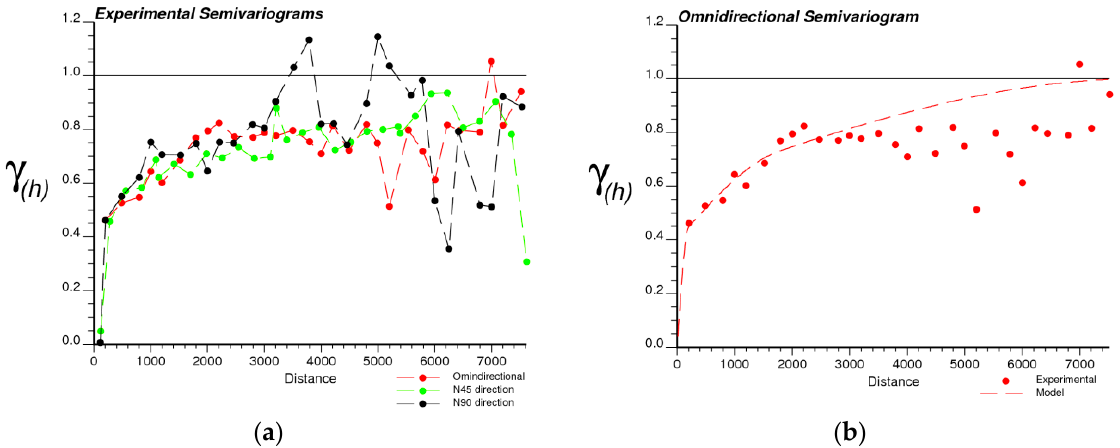
Figure 9. ( A ) Experimental variograms for normal score variable in the directions N45, N90, and omnidirectional and ( B ) the adjusted model for the omnidirectional variogram.